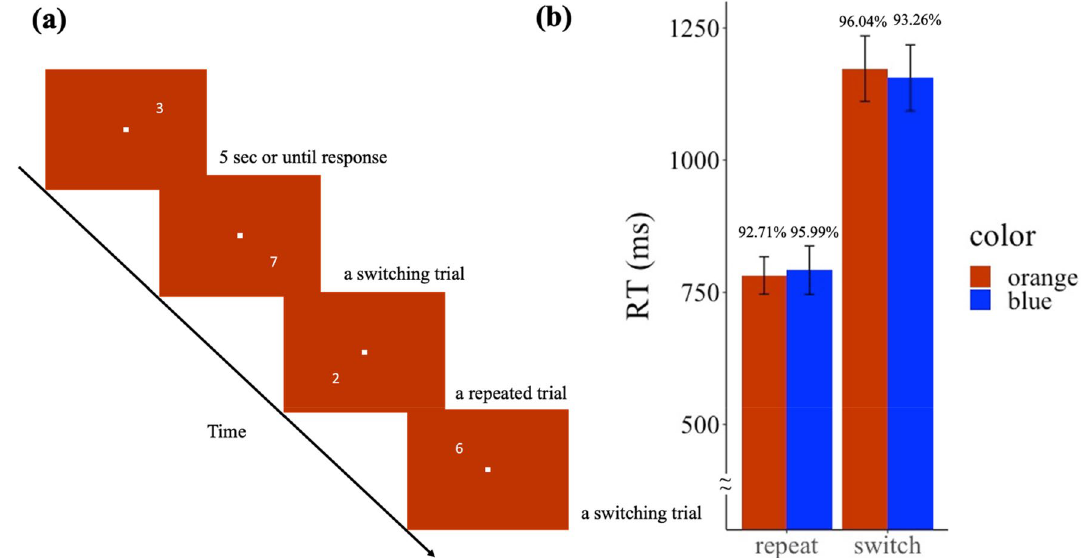
Figure 3. ( a ) The experimental design of Experiment 3. ( b ) Reaction time in repeated and switching trials in Experiment 3. Error bars represent one S.E.M. The number shown above each bar denotes the accuracy of each